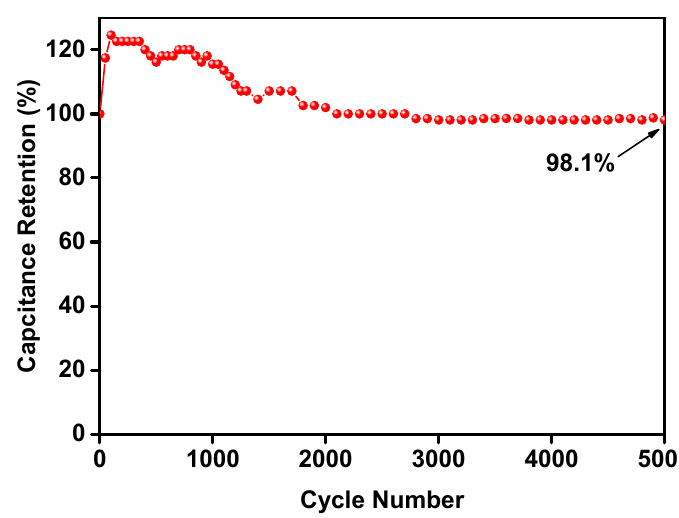
Figure 7. Cycle stability of AC III electrodes measured at 1 A g − 1 .